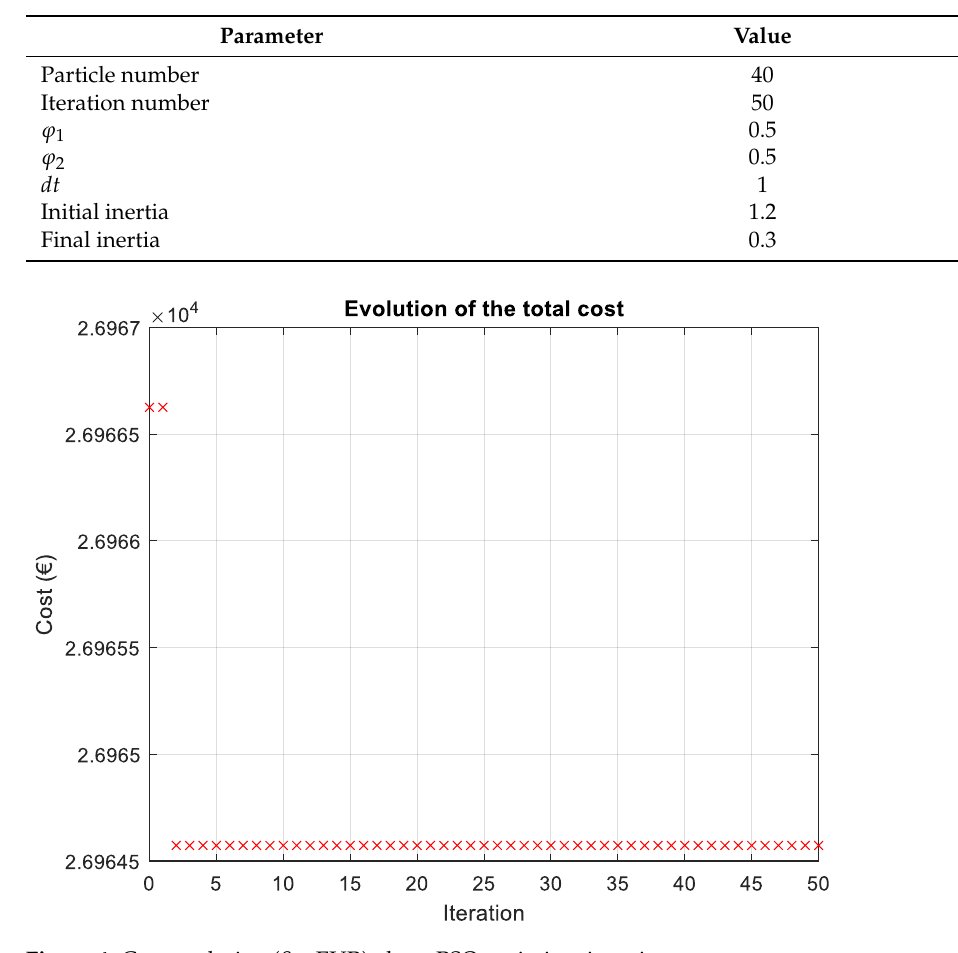
Figure 4. Cost evolution ( € = EUR) along PSO optimizer iterations.